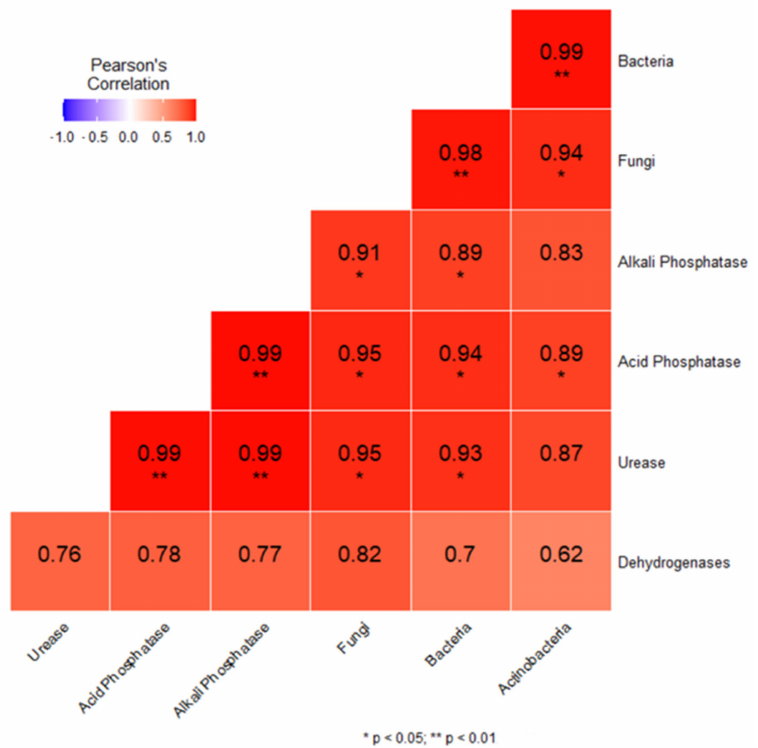
Figure 5. Correlation between soil microbes and soil enzymes; * and ** indicate a significant difference at p < 0.05 and p < 0.01, respectively; bacteria ( × 10 5 cfu/g); fungi ( × 10 4 cfu/g); actinobacteria ( × 10 4 cfu/g); urease (NH 3 µ g/g/h); dehydrogenases ( µ g TPF formed/g soil/h); acid phosphatases ( µ g PNP/g/h) and alkali phosphatases ( µ g